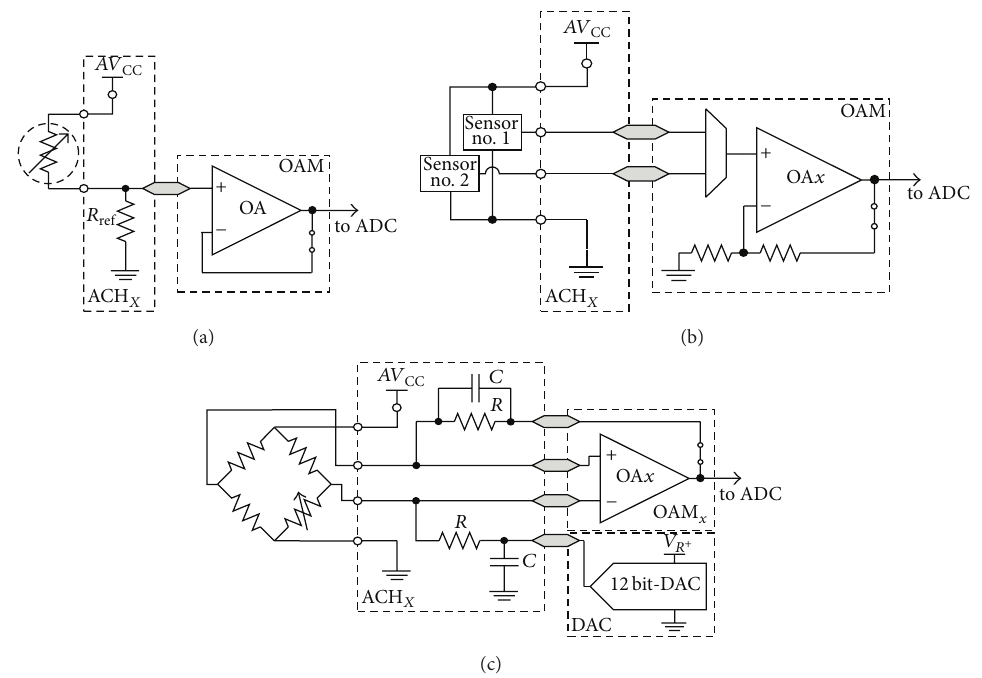
Figure 3: Examples of analog sensor interface. (a) Resistive type. (b) Output voltage. (c) Bridge type.